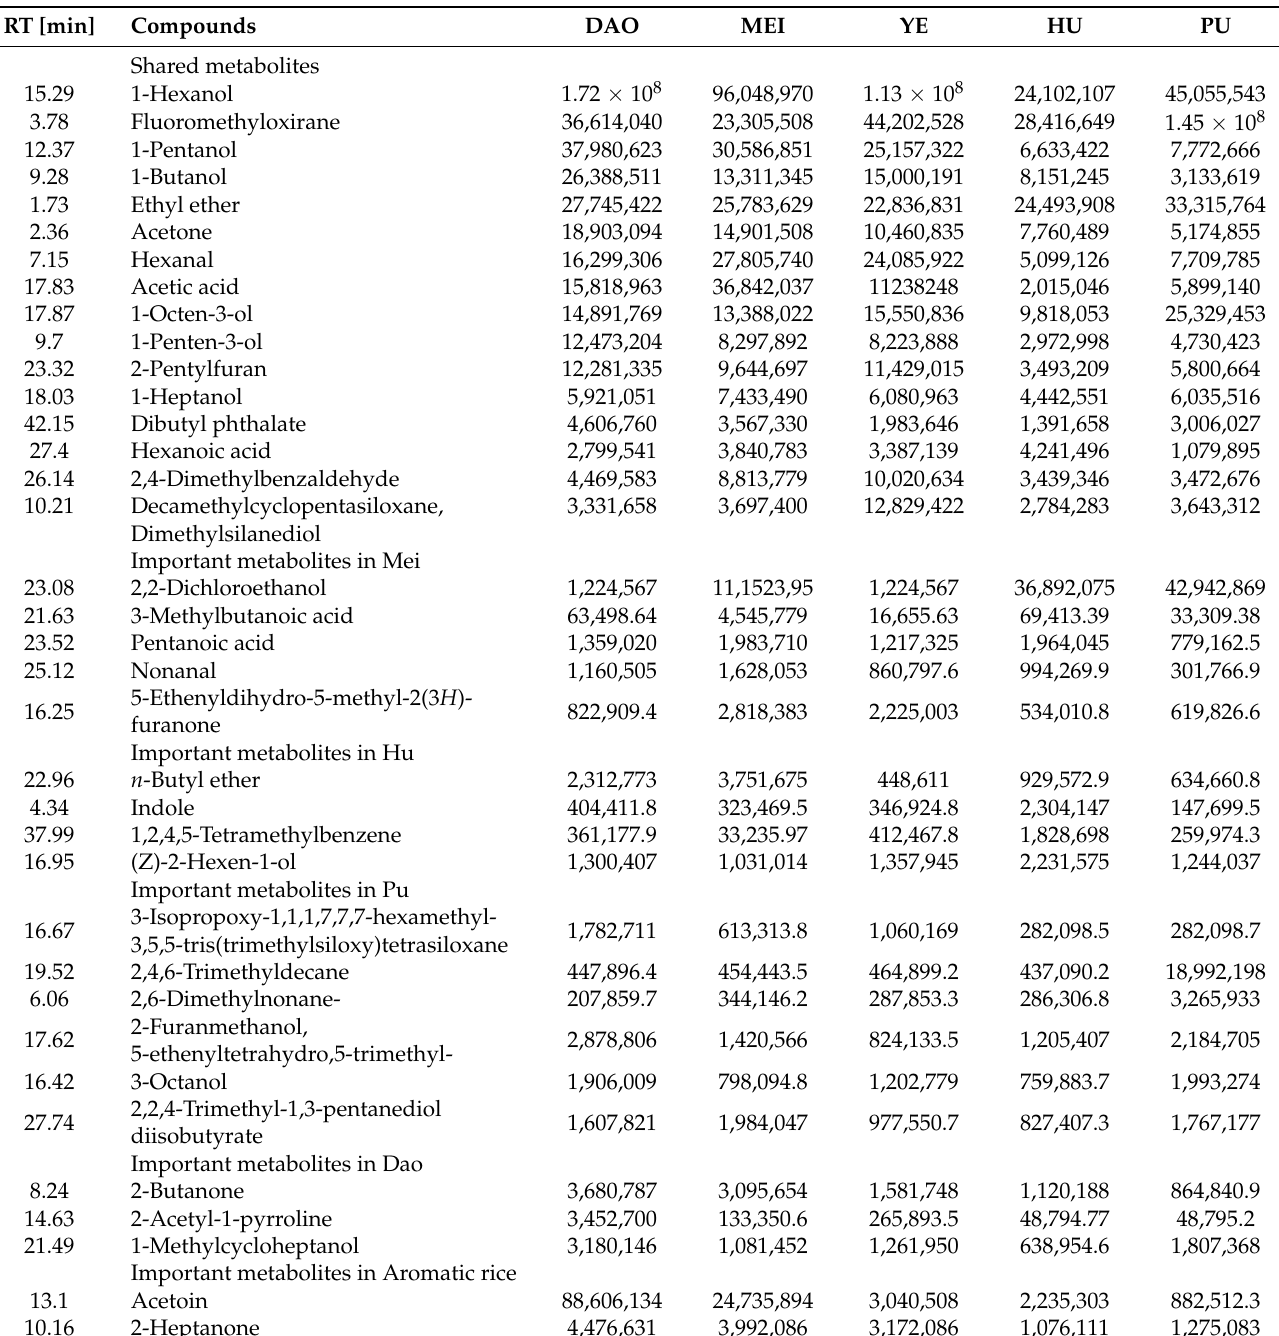
Table 1. The selected VOC metabolites with their relative abundances across all the